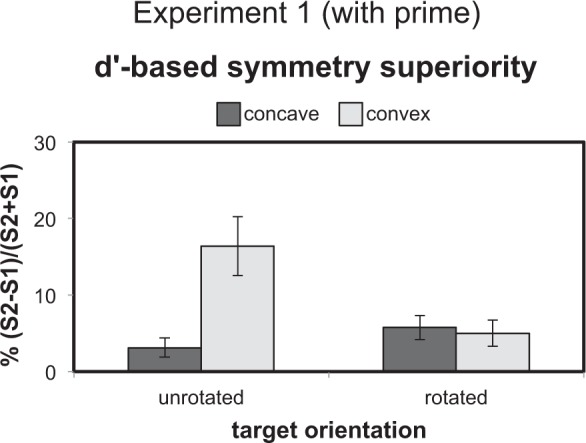
Experiment 1. Mean values (± 1 sem) of d′-based
symmetry superiority in the reduced Rotation × CCP design. Symmetry
superiority was larger than zero in each condition.